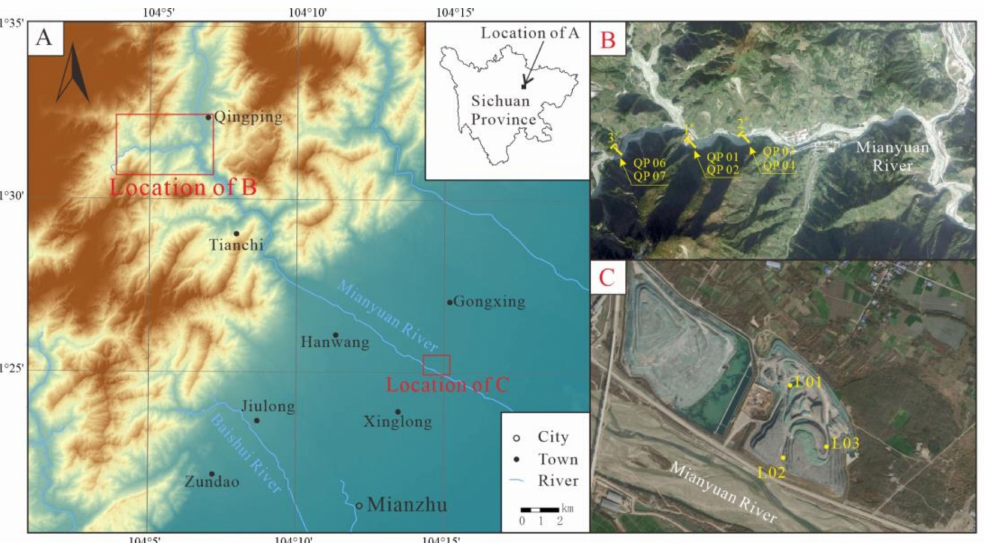
Figure 1. Location map of the phosphorite deposit ( A , B ) and phosphogypsum pile ( C ) along the Mianyuan River, with sampling points indicated. Image from Google Earth software(Google LLC, Santa Clara, CA,